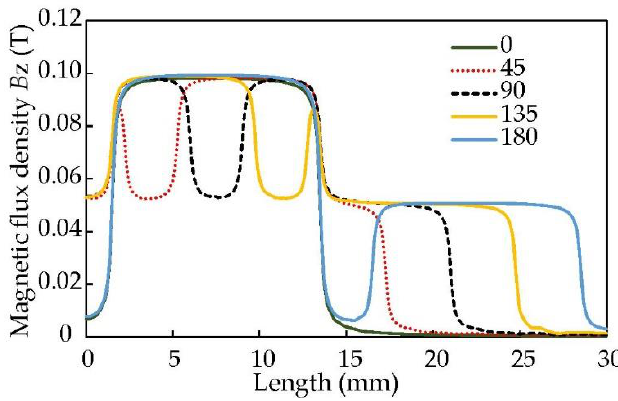
Figure 16. Magnetic flux density axial component.